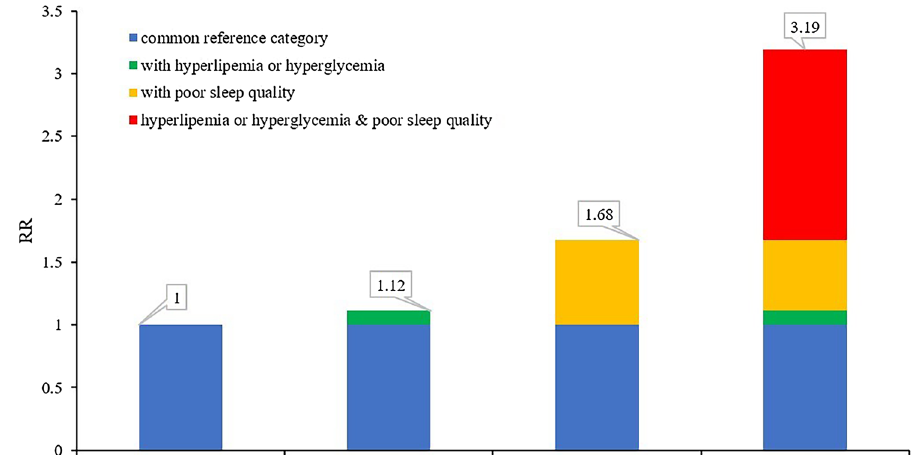
Figure 1. An additive effect of PSQI and hyperlipemia/hyperglycemia for females.